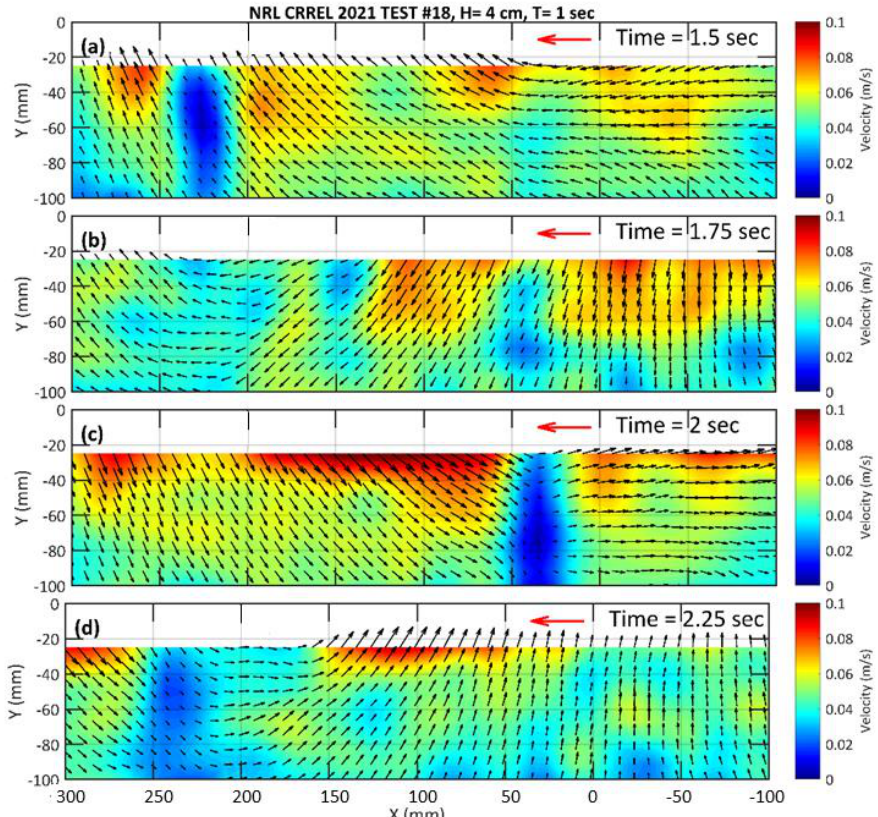
Figure 9. Instantaneous under-ice velocity fields from PIV measurements at time steps of ( a ) 1.5 s, ( b ) 1.75 s, ( c ) 2 s, and ( d ) 2.25 s. Colors represent velocity magnitudes. The coordinate X is the distance along the tank. The wavemaker is located beyond the right edge of the image, at X = − 268 cm. (Note that the X-axis direction in these processed results has been flipped from that shown for the raw data in Figure 8.) The coordinate Y is the vertical distance to the mean water line of the tank. Black arrows indicate the flow direction and the velocity magnitude is indicated by the arrow length and color shadings. The red arrow indicates the wave propagation direction. Data are again from trial 18.